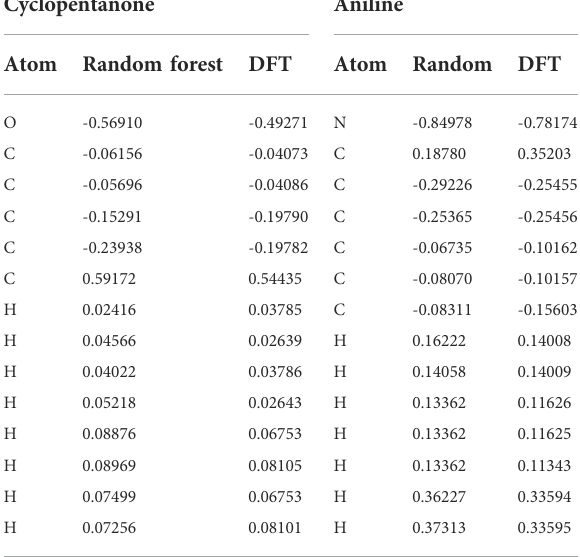
TABLE 1 Comparison of predicted partial charges from the random forest regression model with DFT charges.